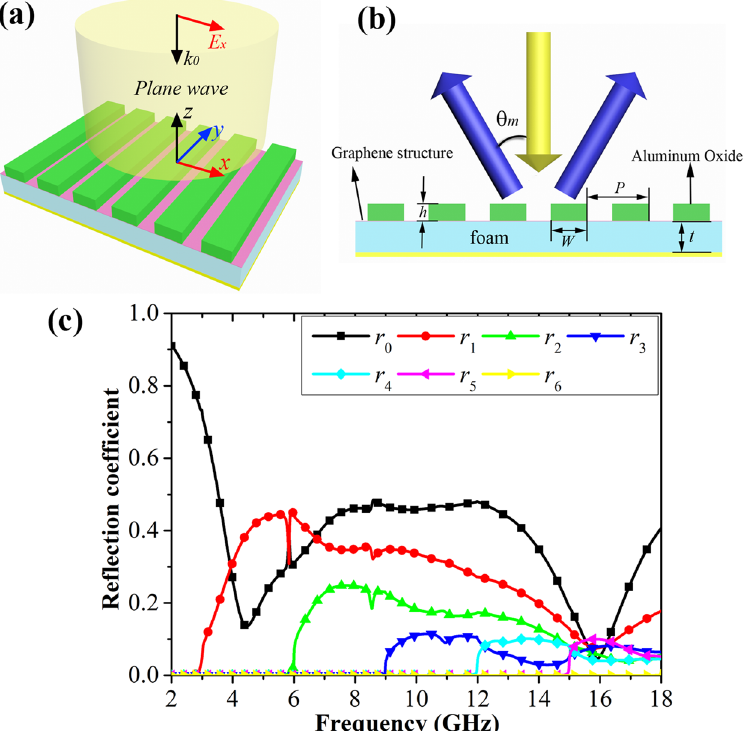
Figure 1. Schematic of the proposed RCS reduction structure and its simulated reflection coefficients. ( a ) Three-dimensional illustration of the 1D grating integrated Salisbury screen. ( b ) Side-view. ( c ) The corresponding reflection coefficients of different reflection orders. The geometrical parameters are optimized as follows: w = 65 mm, h = 3 mm, p = 100 mm, and t = 5